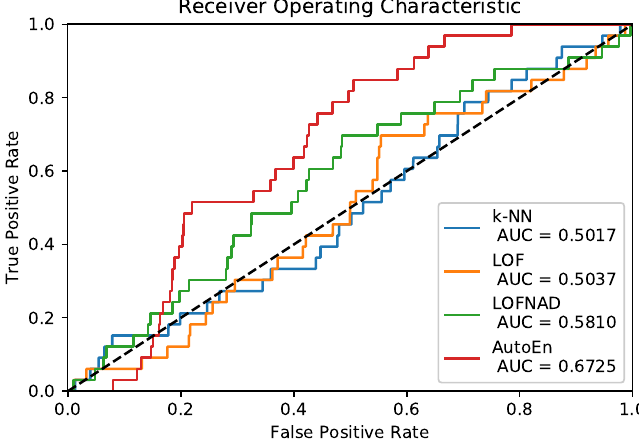
Figure 4. The receiver operating curves (ROC) and AUC